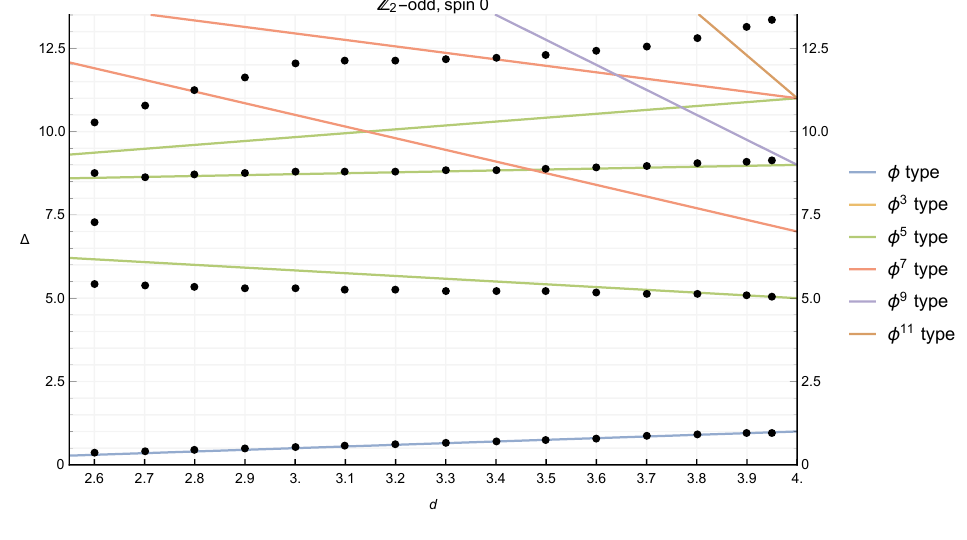
Figure 11 . Z 2 -odd operators of spin 0.